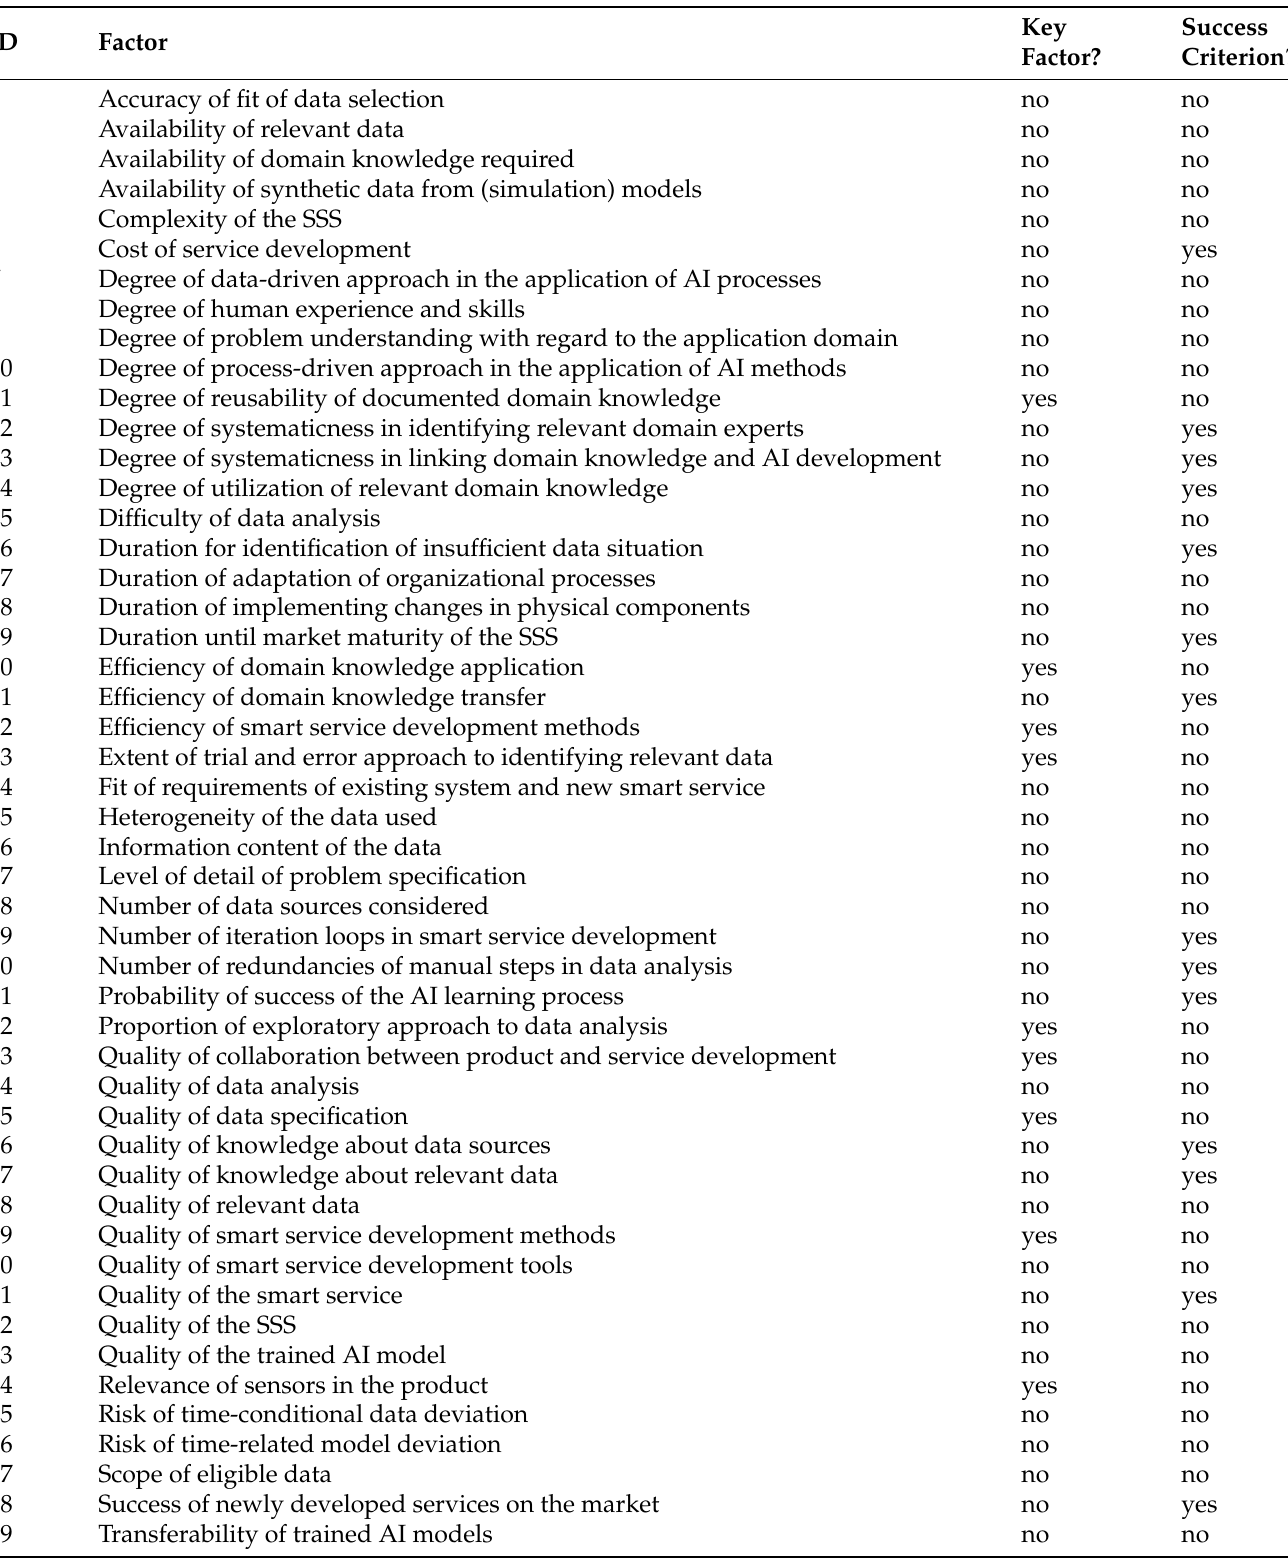
Table A2. Identified relevant